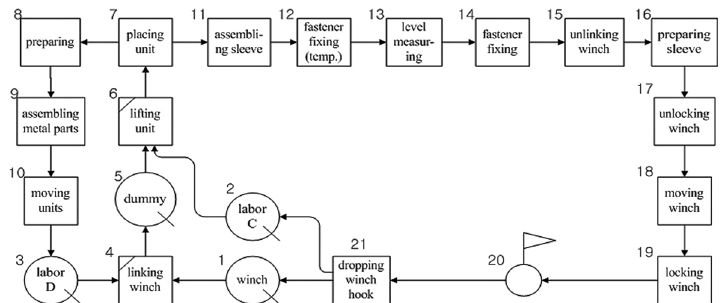
Fig. 4. Initial simulation model for the installing